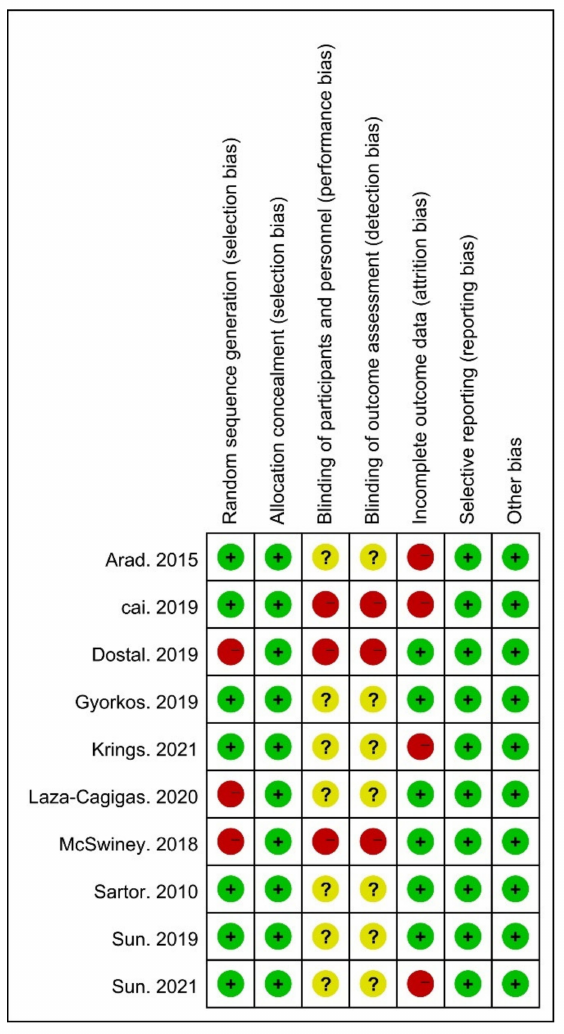
Figure 2. Risk of bias (ROB) results of quality assessment within included studies. Risk of bias levels: low (green or “+”), unclear (yellow or “?”), and high (red or